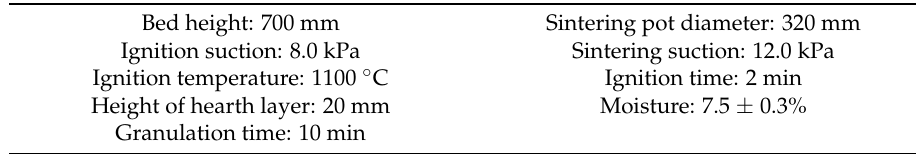
Table 4. Parameters of the sintering